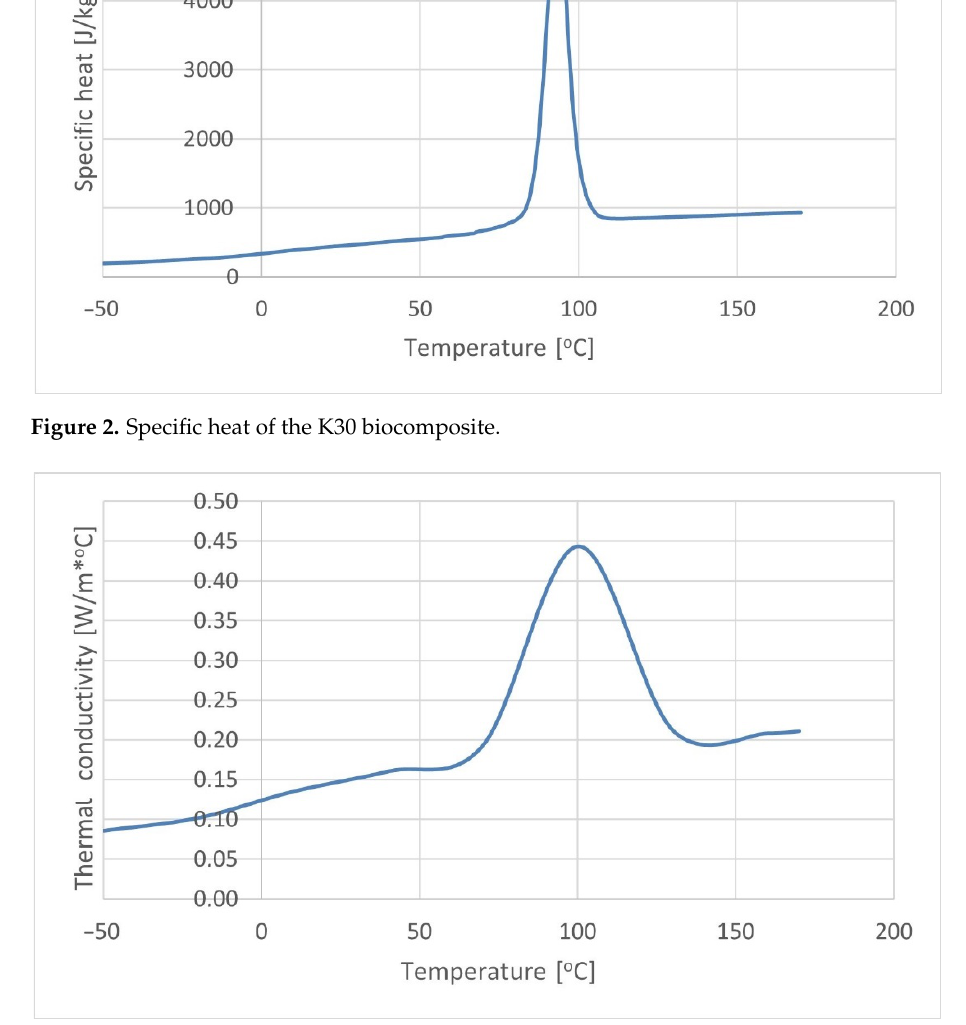
Figure 3. Thermal conductivity of the K30 biocomposite.